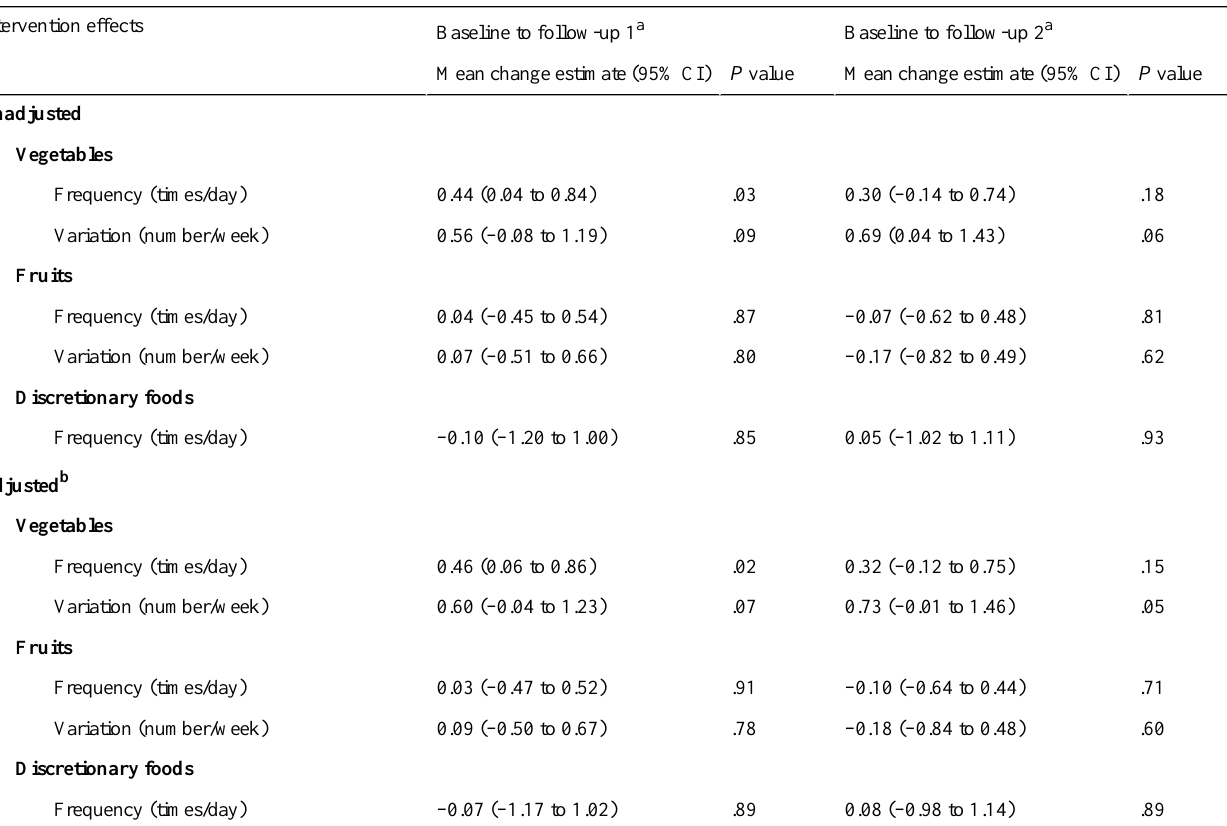
Table 5. Intervention effects of the Food4toddlers study on food intake outcomes from baseline to both follow-up time points (n=291).